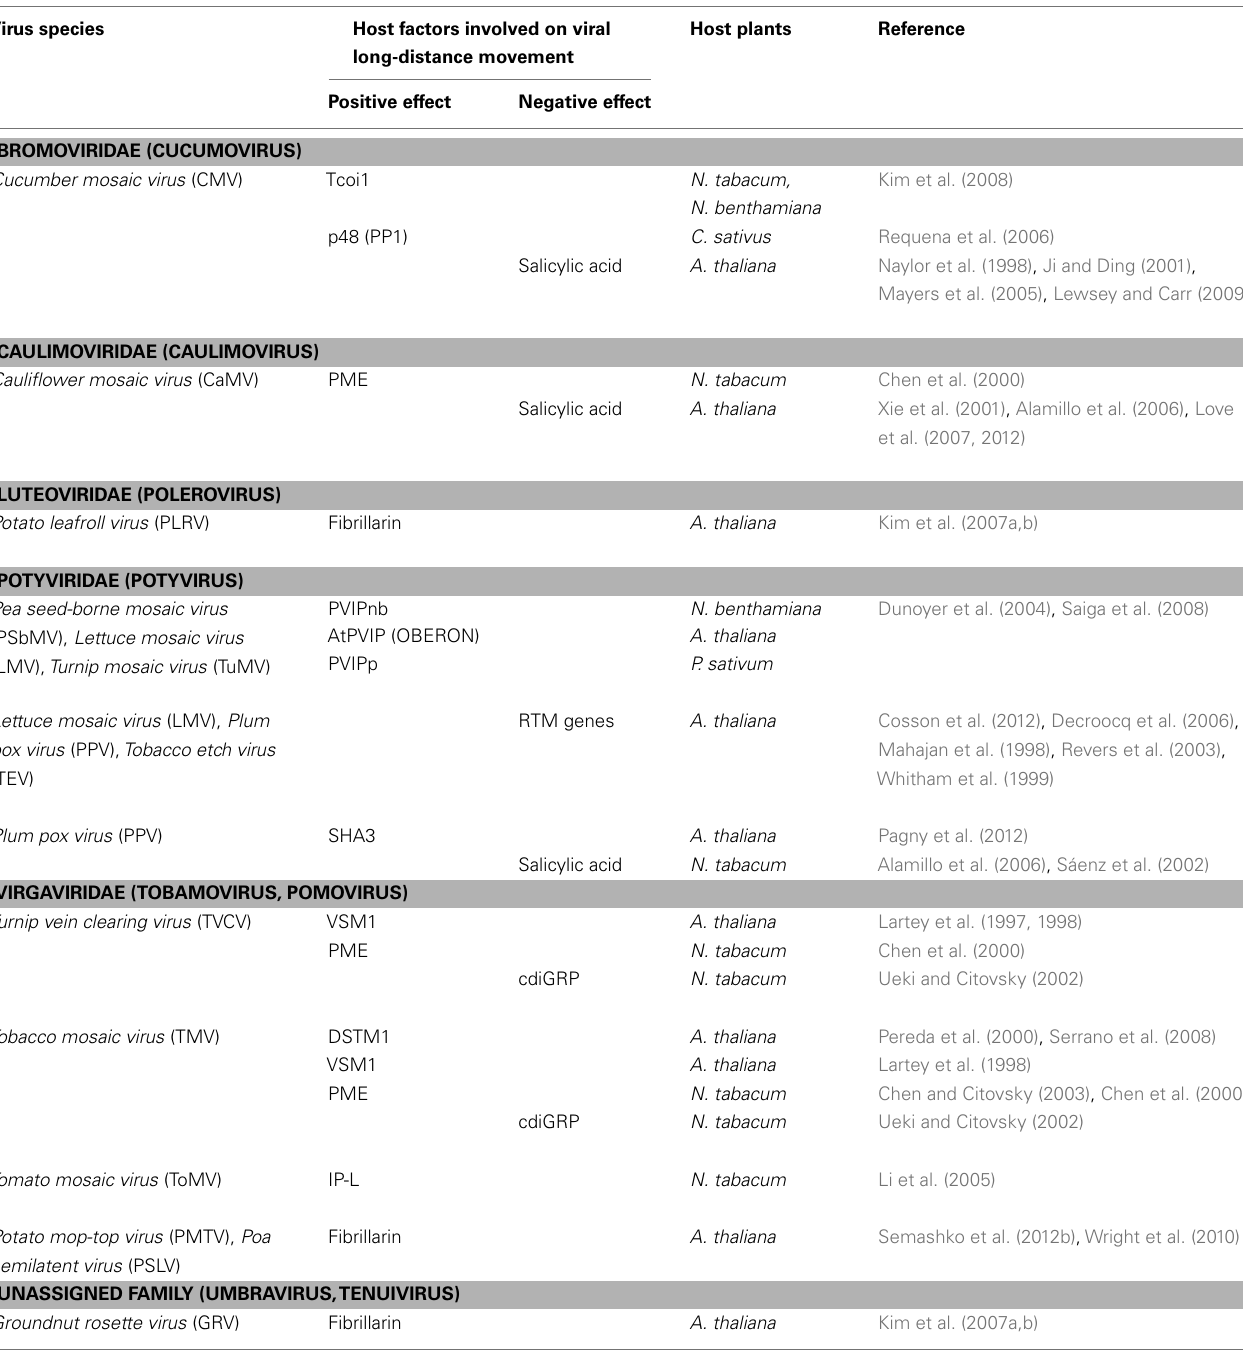
TableA2 | Host factors known or suspected to be involved in virus long-distance transport. Virus